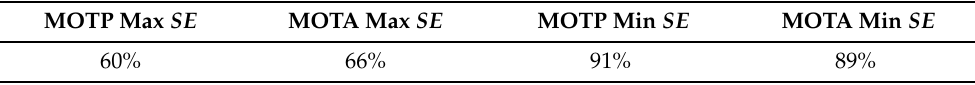
Table 3. Average of the minimum and maximum MOTP and MOTA for all the experiments.